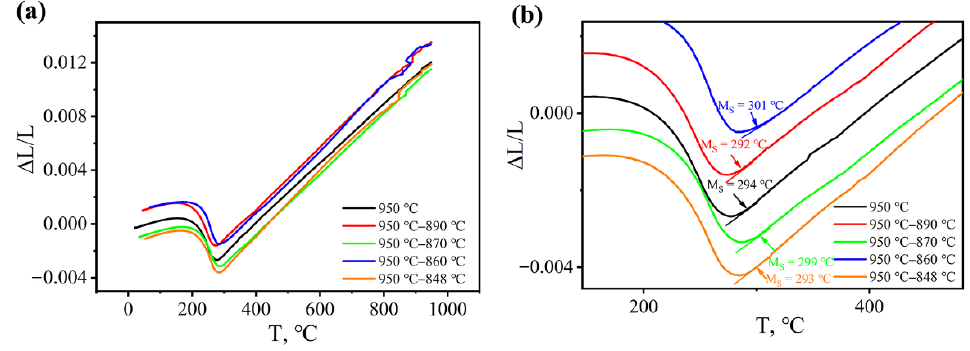
Figure 4. ( a ) Temperature–expansion curves at different austenitization temperatures; ( b ) Enlarged figure of ( a ) located at the transformation point.